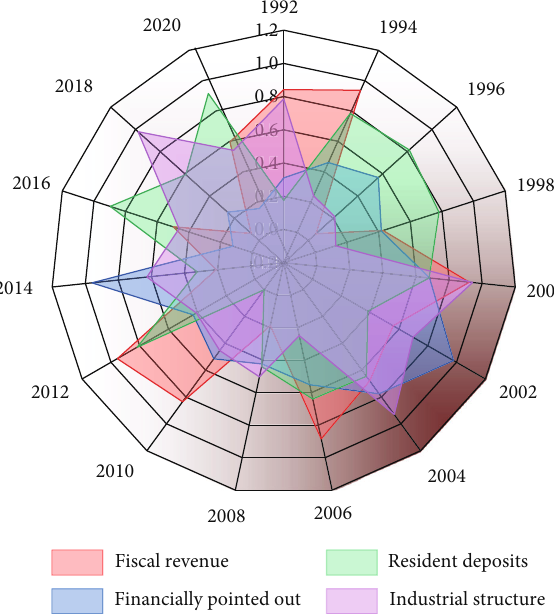
Figure 10: Four control variables as a function of